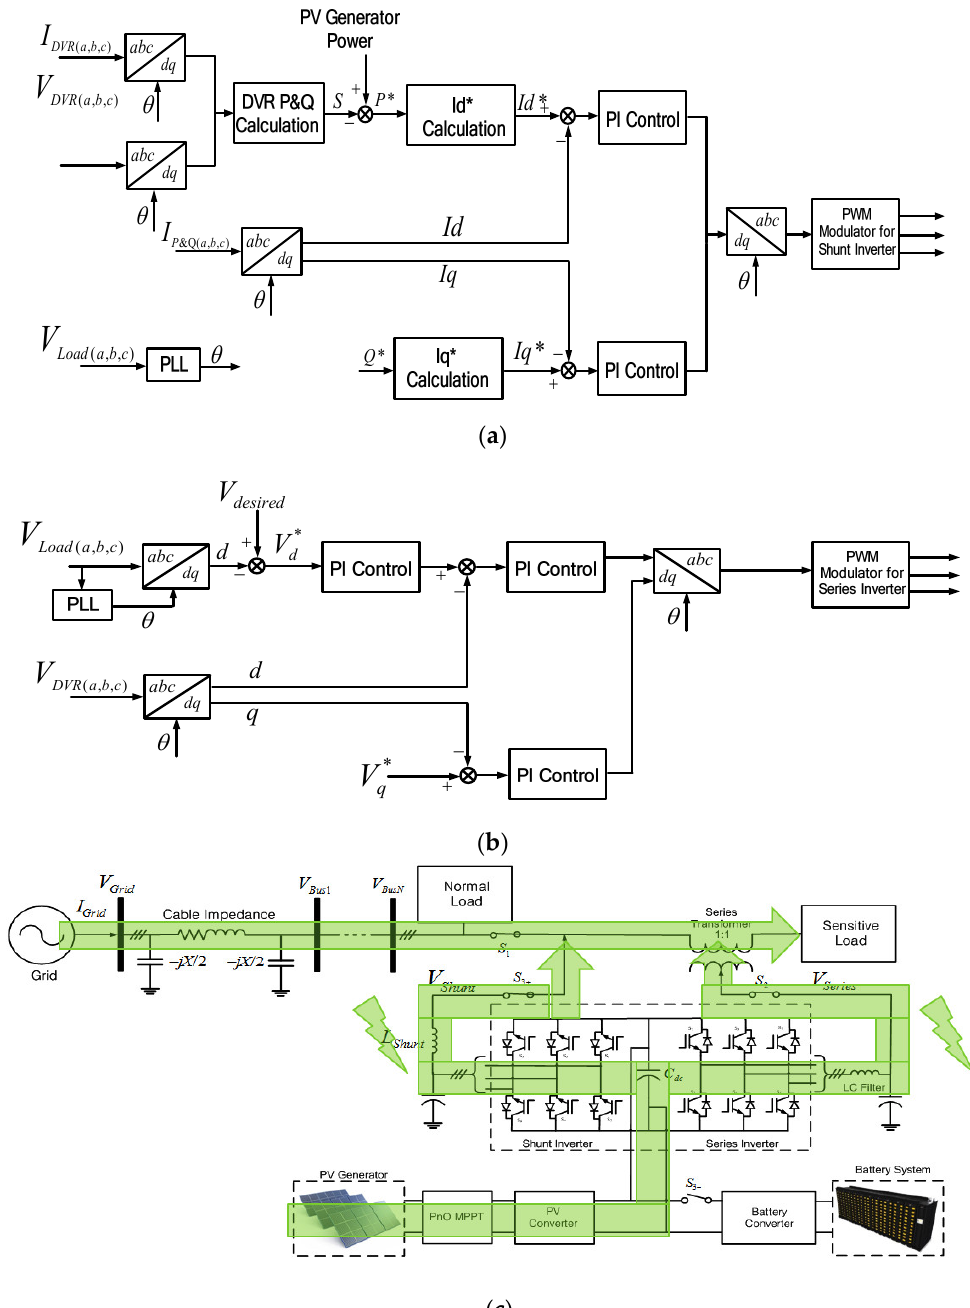
Figure 7. Voltage compensation mode: ( a ) Control scheme for shunt inverter; ( b ) control scheme for series inverter; ( c ) power flow condition.